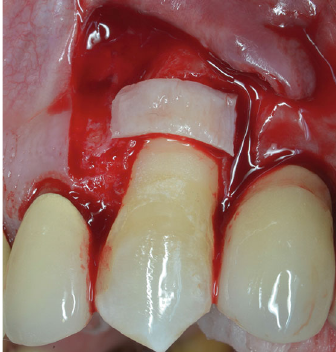
Figure 9: The connective tissue graft is attached with the fi brin- fi bronectin glue to the root at the MRC level.